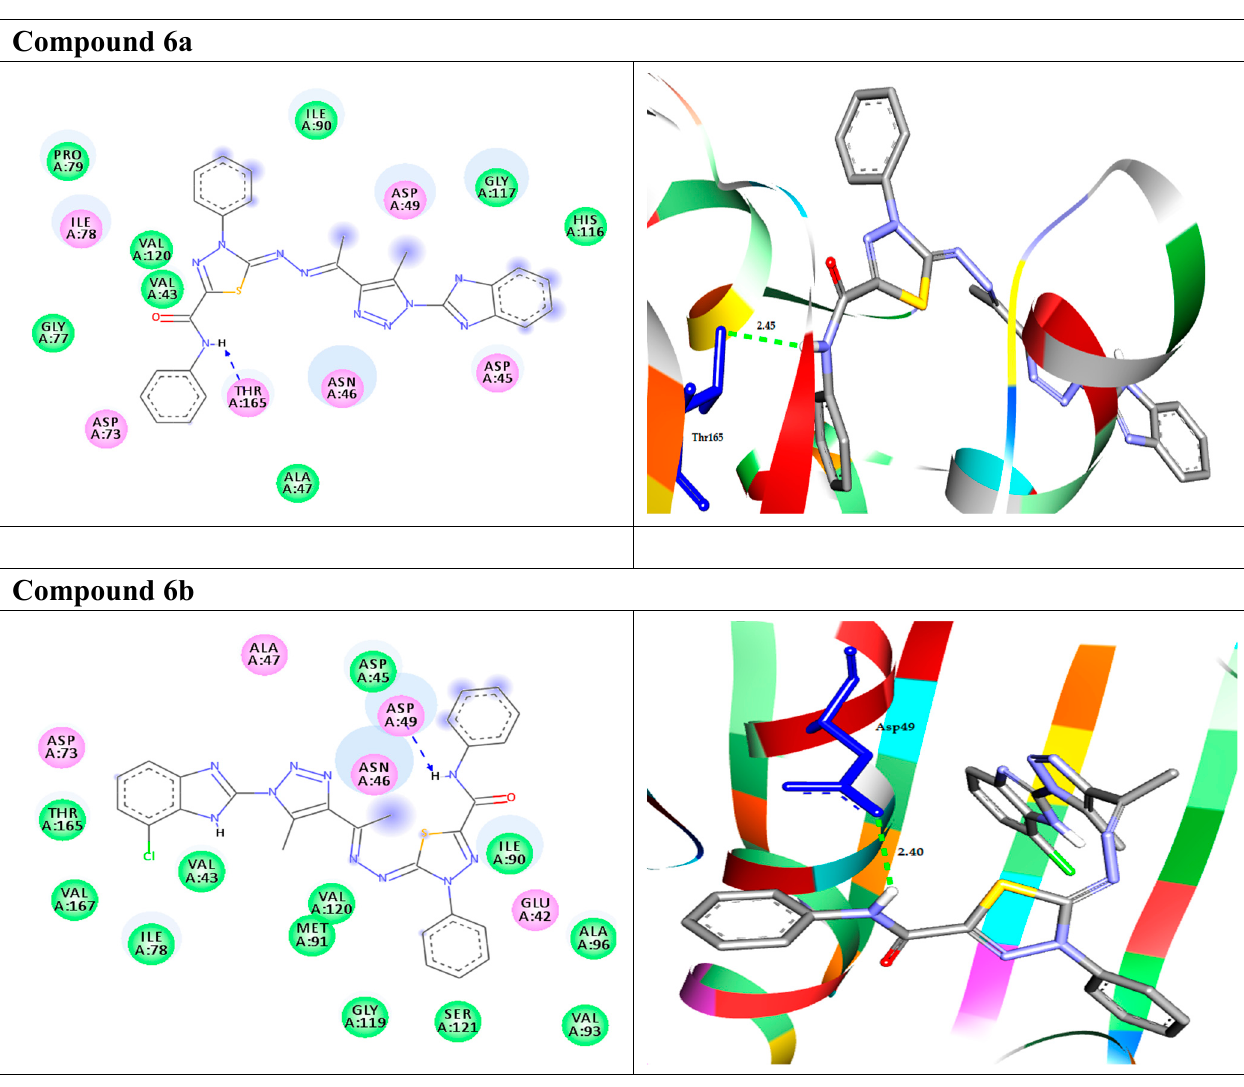
Figure 2. The molecular interactions of the best docked compounds 6a and 6b with the target enzyme DNA gyrase B. Left side (2D): the residues are represented in 3 letter codes. Hydrogen bonds are represented by green and blue lines and pi- interactions are represented by orange lines. Right side (3D): the docked compounds are represented by gray stick models, and the active site pockets are shown by blue stick models. H-bond interactions are shown in green dashed lines. π - interactions are shown in orange lines.